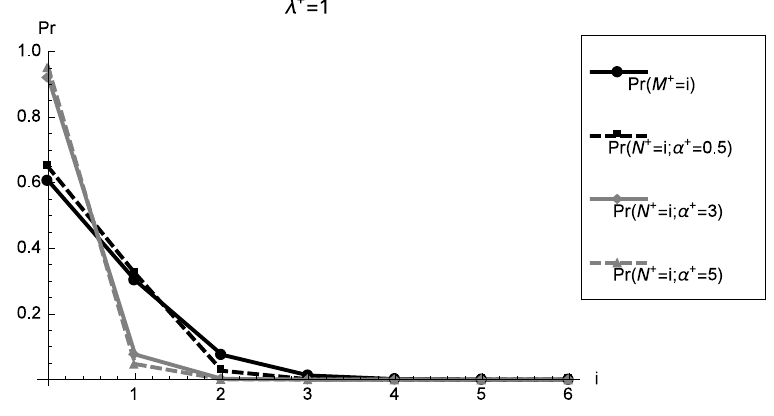
Figure 12 { Plots of the density of X ′′ (cid:24) CDNCB ( (cid:11) 1 ; (cid:11) 2 ; (cid:21) 1 ; (cid:21) 2 ) for (cid:11) 1 = (cid:11) 2 = 1 and selected values of (cid:21) 1 ; (cid:21) 2 .